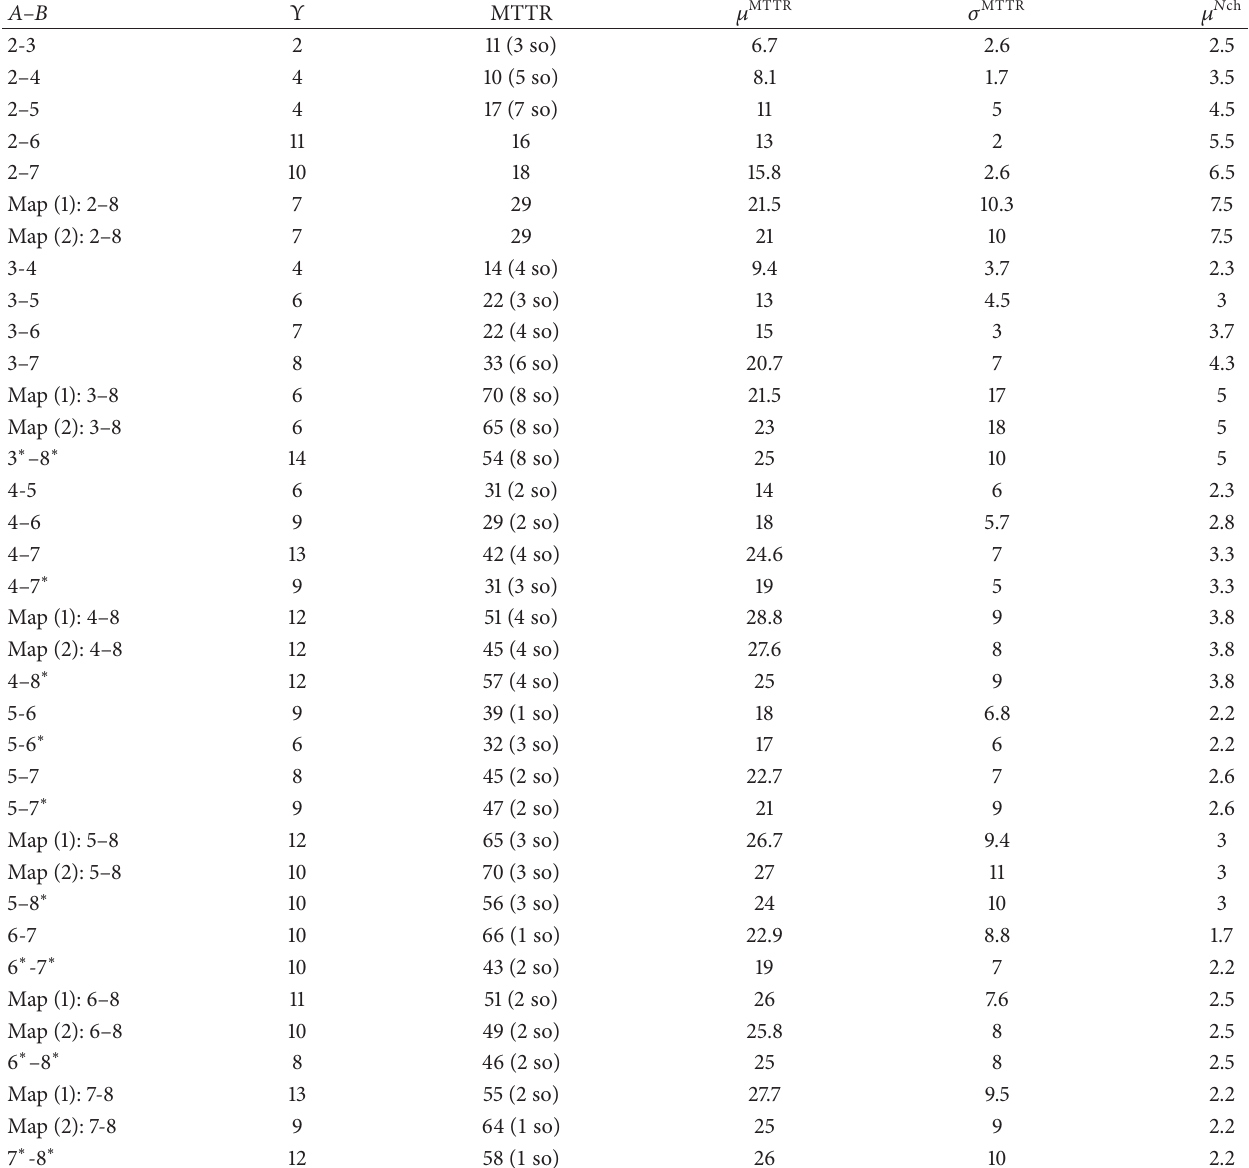
Table 3: MtQS-DSrdv in ACHv: RDV in a larger period of